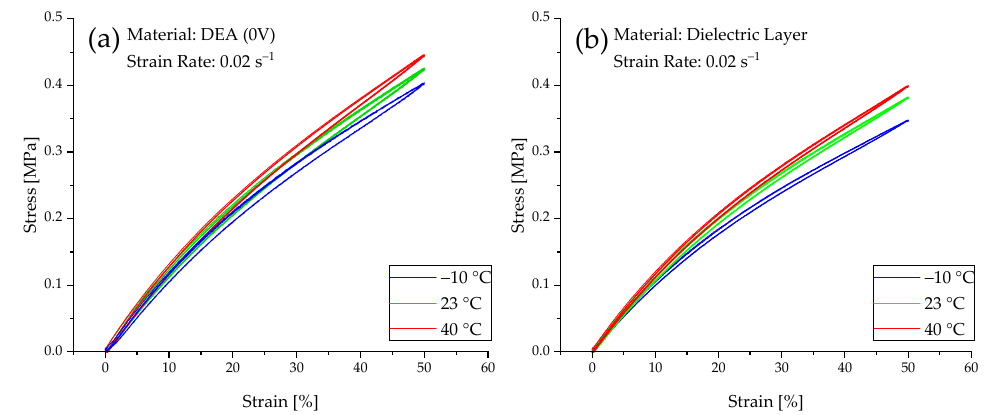
Figure 6. Stress–strain hysteresis at a strain rate of 0.02 s − 1 for the ( a ) DEA (no activation) and ( b ) dielectric layer at different